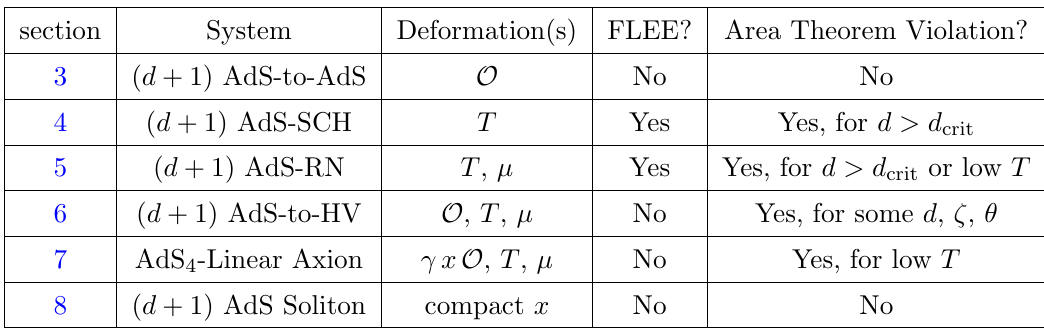
Table 1. Summary of our main results, discussed in detail in this